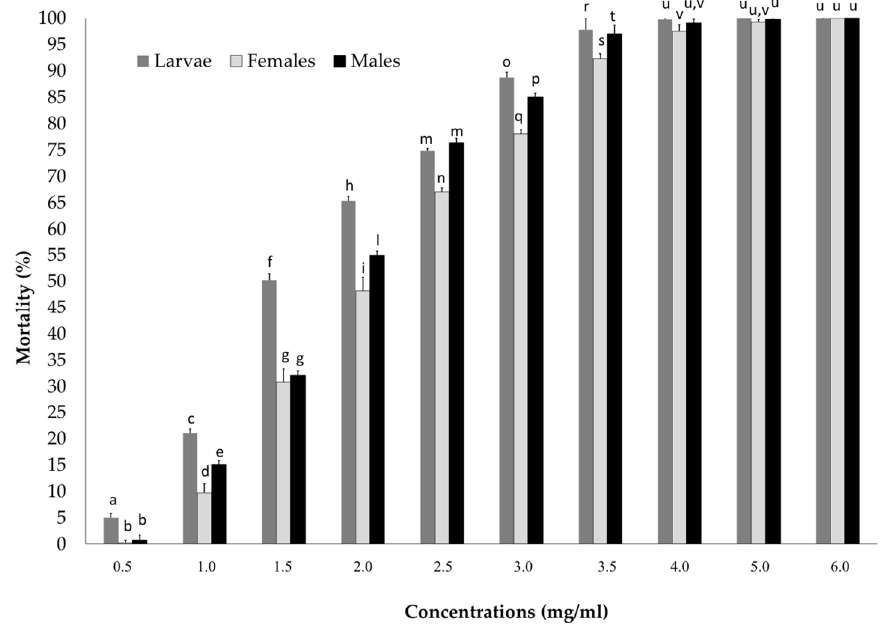
Figure 2. Mortality percentage of Rhynchophorus ferrugineus larvae, females, and males treated with Bacillus thuringiensis in a trial conducted at different lengths of time. Bars indicate standard deviations over 3 replicates of 10 individuals. Significant differences ( p < 0.05) among the percentage of mortality are indicates with different letters. Table 1. Probit analysis of concentration-mortality of later instar larvae, females, and males of Rhynchophorus ferrugineus to Bacillus thuringiensis . NoI: number of insects; LC: lethal concentration; EC: estimated concentration; LC50: median lethal concentration (mg/mL); LC90: lethal concentration for 90% mortality; CI: confidence interval (mg/mL). Table 2. The toxicity probit analysis of median lethal time of Bacillus thuringiensis against later instar larvae, females, and males of Rhynchophorus ferrugineus. NoI: number of insects; LT50: Median Le- thal Time (hours); CC: Correlation Coefficient; CI: confidence interval (hours).